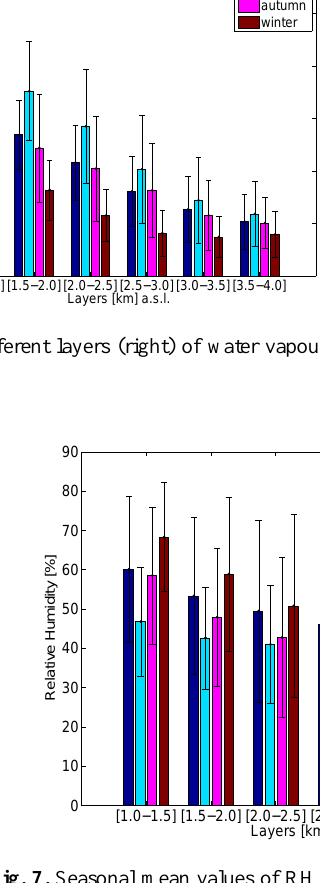
Fig. 7. Seasonal mean values of RH for different layers. The error bars indicated the standard